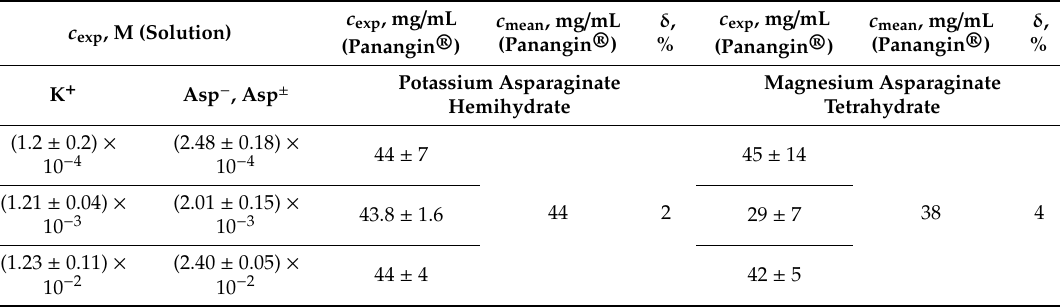
Table 6. Calculations of the active substance’s concentration in Panangin ®